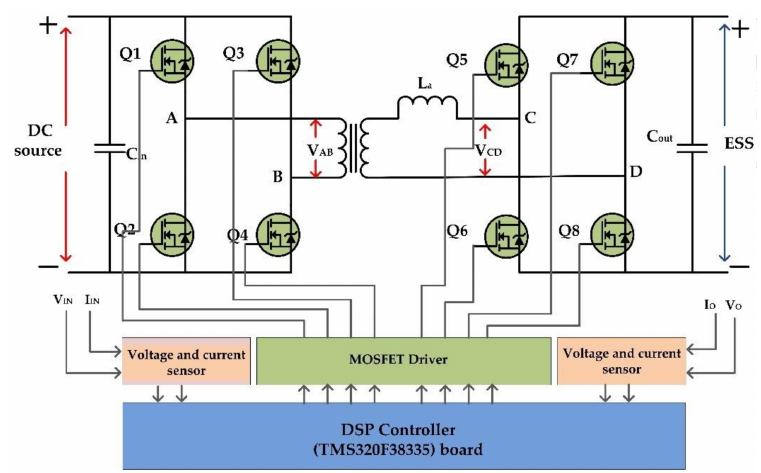
Figure 4. Dual Active Bridge bi-directional DC-DC Converter